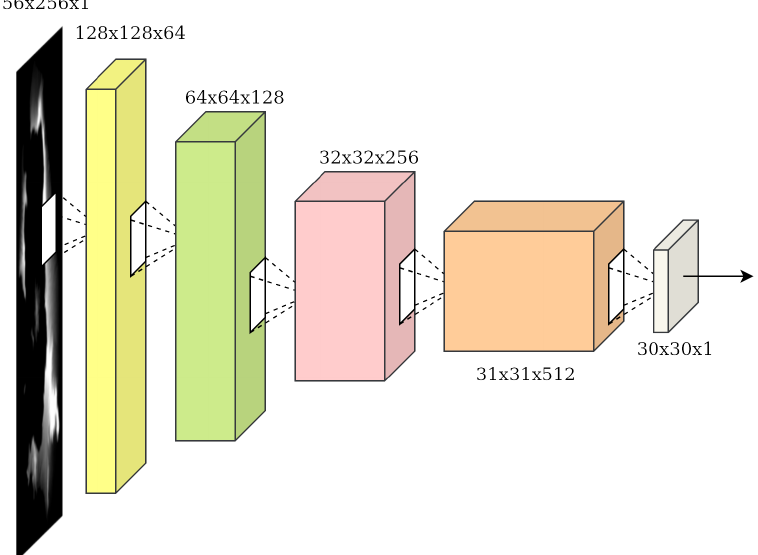
Figure 1. The discriminator architecture of choice: PatchGAN [55]. The discriminator decides whether its input is from the true data distribution based on local information by concentrating on the fidelity of individual image